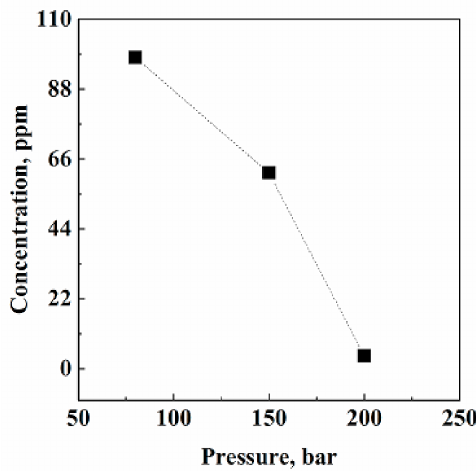
Figure 2. Acetone residual concentration in Fluni after SC-CO 2 extraction performed at different operative pressures and at 40 ◦ C and 0.7 kg/h CO 2 flow